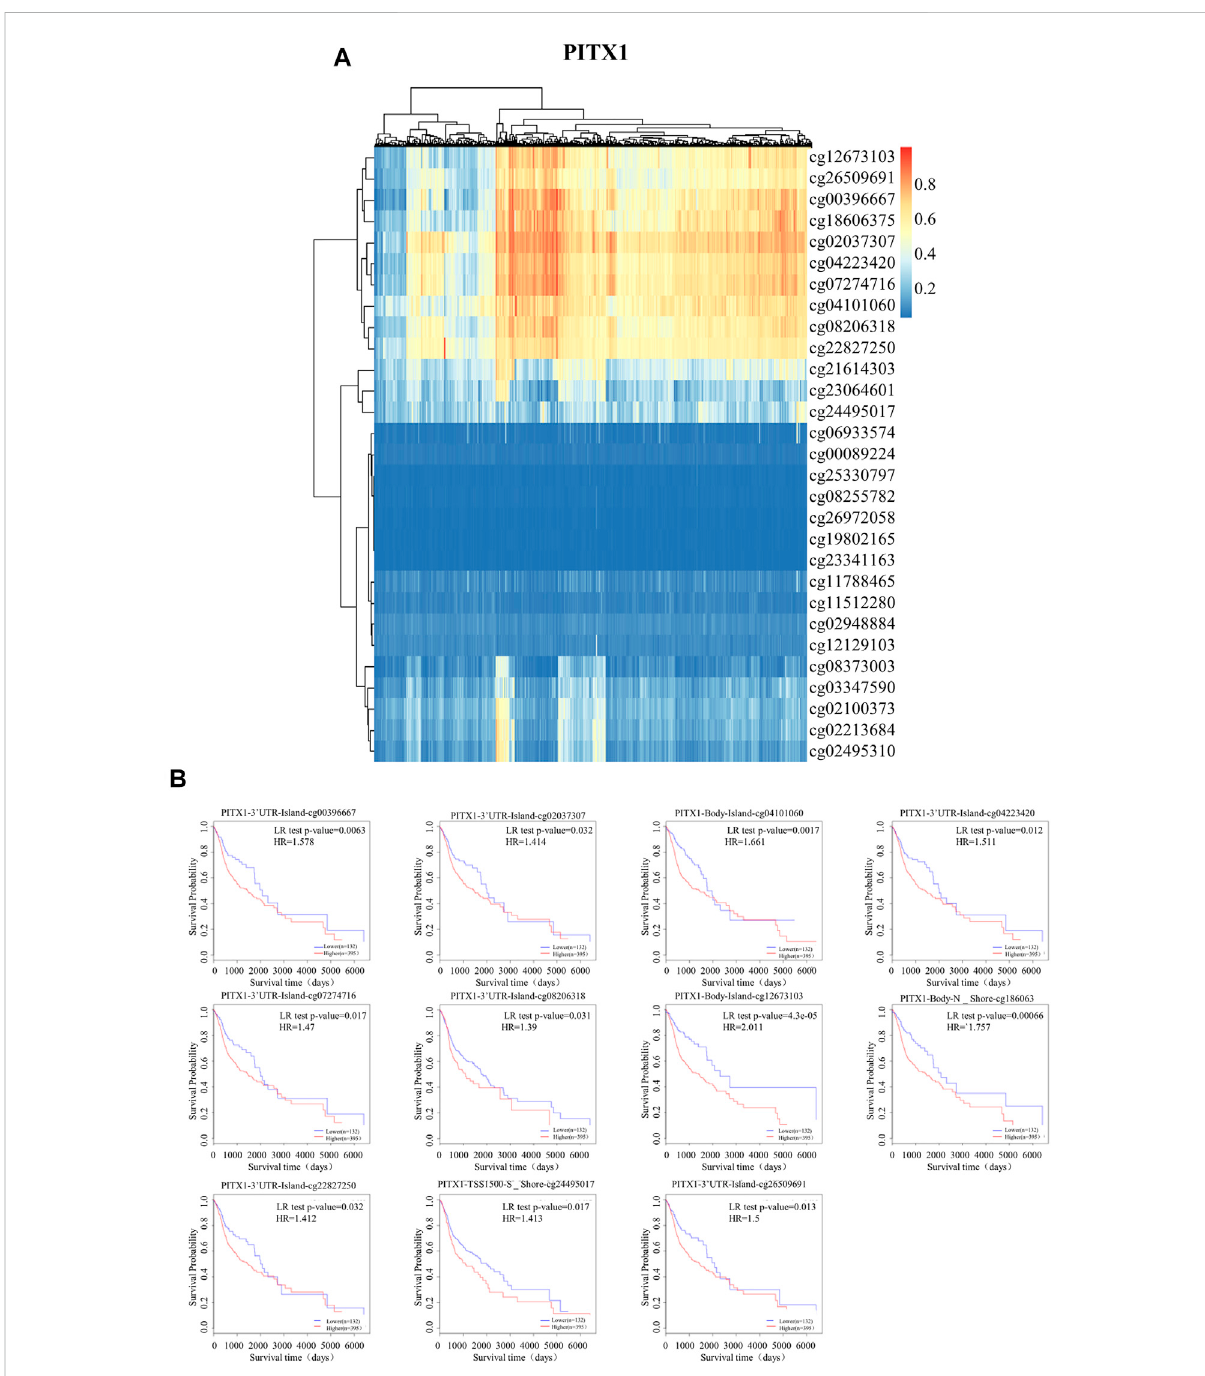
FIGURE 5 DNAmethylationofPITX1andHNSCprognosis. (A) TheDNAmethylationof PITX1 wasdeterminedusingMethSurv; (B) Theprognosticvaluesof CpGs in PITX1 , based on Kaplan-Meier survival analysis. Red to blue: high expression to low